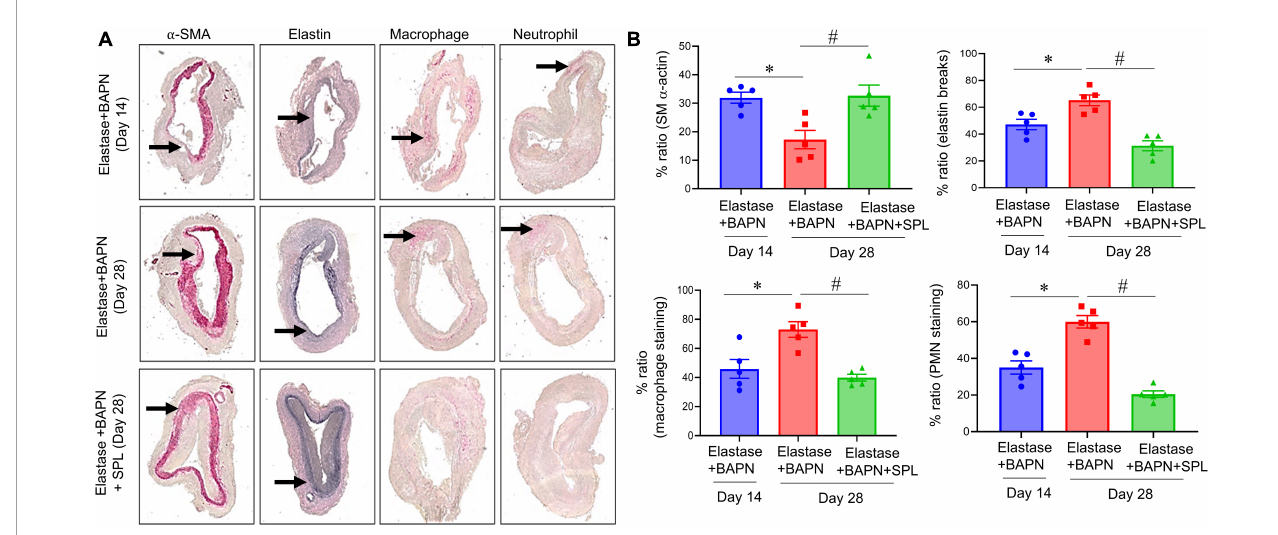
FIGURE5 Spironolactone treatment inhibits leukocyte infiltration and preserves the aortic morphology during chronic AAA formation. (A) Comparative histology displayed a marked increase in SM α -actin expression, as well as decrease in elastin fiber disruption and leukocyte (macrophage and PMN) infiltration in SPL-treated mice. Arrows indicate areas of immunostaining n = 5/group. (B) Quantification of histological immunostaining demonstrated a significant preservation of aortic integrity and decrease in immune cell infiltration in SPL-treated aortic tissue compared to untreated mice. ∗ P < 0.02; # P < 0.01.